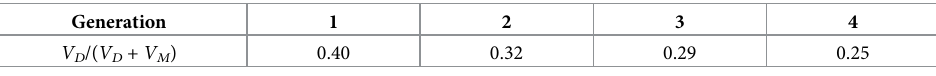
Table 3. Relative volume of daughter cells by generation. Where V M is the mother cell volume and V D is the daughter volume. This table was adapted from Table 2 in [37].